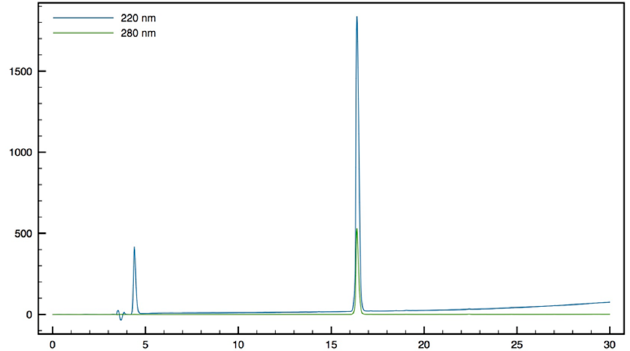
Figure 14. HPLC profile of H-Tbt - β 2,2 h bis-Arg-OMe 11 . Figure 14 . HPLC profile of H-Tbt- β 2,2 h bis-Arg-OMe 11 . Figure 14 . HPLC profile of H-Tbt- β 2,2 h bis-Arg-OMe 11 .